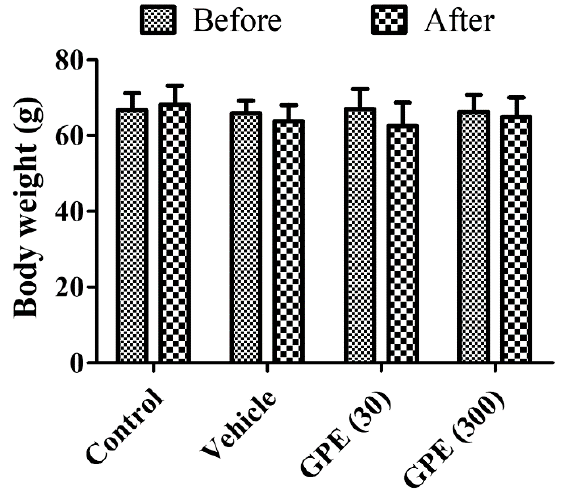
Figure 1. Body weight in the control, vehicle-treated ischemic (Vehicle), 30 mg/kg Gynura procumbens roots (GPE-R)-treated ischemic (GPE30), and 300 mg/kg GPE-R-treated ischemic (GPE300) groups. There are no significant changes in body weight before and after ischemia or GPE-R treatment. Error bars represent standard errors of the